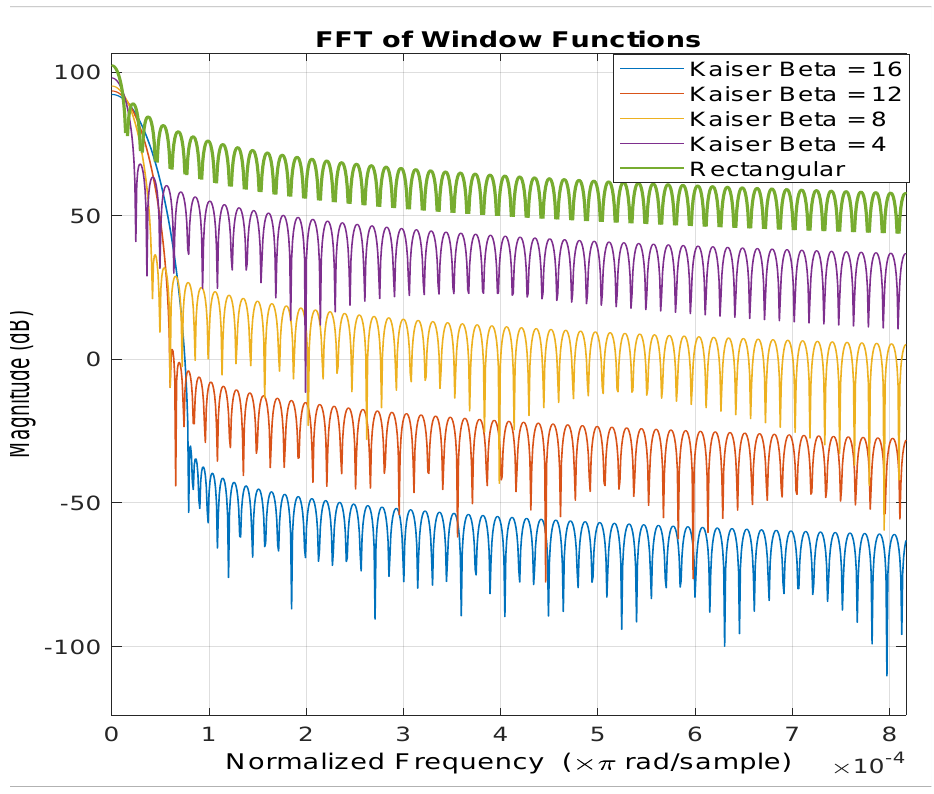
Figure 2. Zoomed-in frequency domain comparison of windows used (of length 131,072 samples).